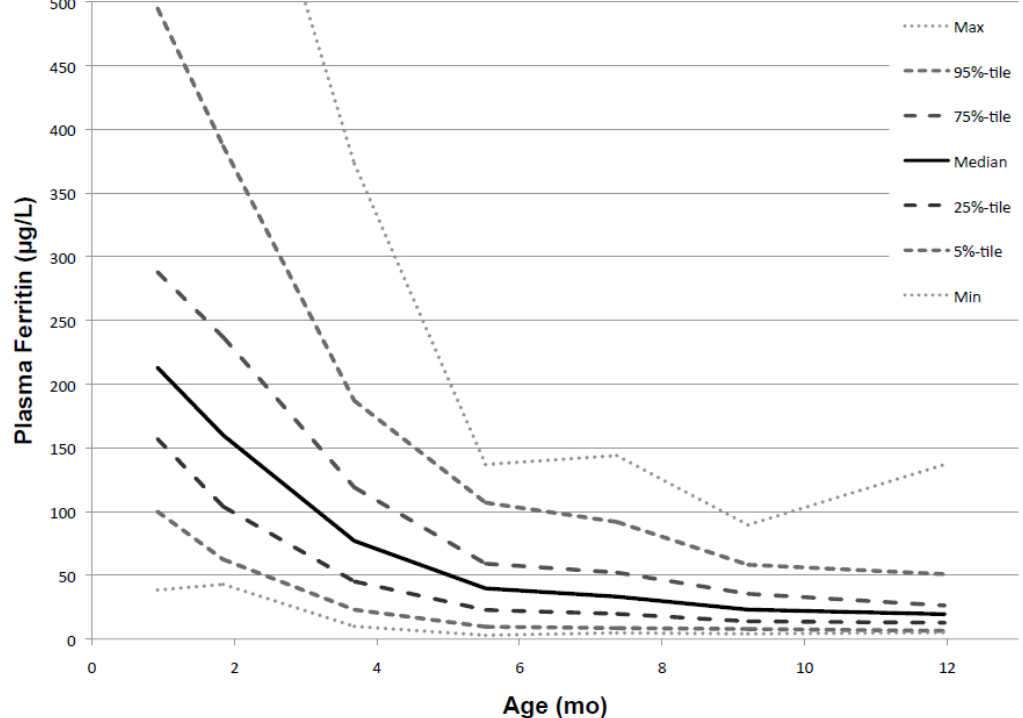
Figure 5. Percentile values for PF from 1 to 12 months (males and females